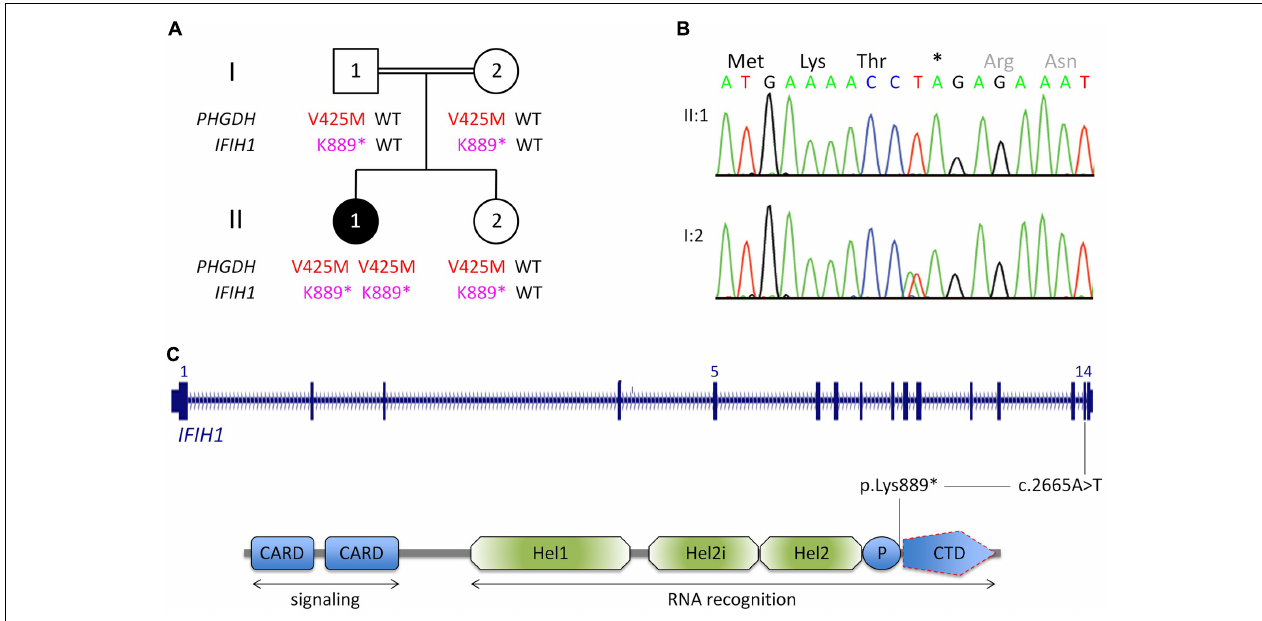
FIGURE 1 | Genetic analysis. (A) Pedigree of the Egyptian family reported herein. The index patient, II:1, is affected by 3-phosphoglycerate dehydrogenase deficiency, as indicated by homozygosity for a previously reported LoF mutation in PGHDH , p.Val425Met. In addition, she is homozygous for a nonsense mutation